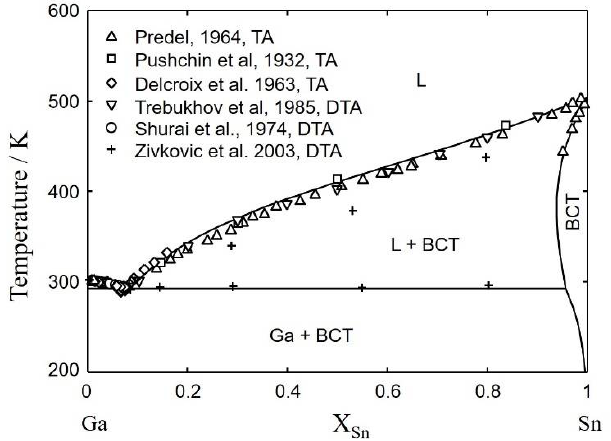
Figure 1. Calculated phase diagram of Ga-Sn along with experimental data from [37–42]. Danilin and Yatsenko [45] and Katayama et al. [46] determined activity in the liquid solution using the Electromotive Force (EMF) method at 1063 K and 1073 K, respectively. Zivkovic et al. [42] determined the activity in the liquid solution using DTA. Mixing enthalpy of liquid Ga-Sn alloy was measured by Bros et al. [47] at 742 K, Bros and Laffitte [48] at 513 K, Gambino et al. [49] at 723 K, and Predel et al. [50] at 623 K using calorimetry. Skoropanov et al. [51] and Zivkovic et al. [42] determined the mixing enthalpy of liquid using DTA at 743 K and 1000–1200 K, respectively. The calculated activity and mixing enthalpy of liquid solution are shown in Figure 2a,b, respectively. These calculated ther- modynamic properties with a single positive parameter are in good agreement with the respective experimental data [42,45–51].